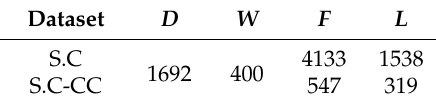
Table 3. The statistics of the S.cerevisiae (S.C) and S.cerevisiae-cellular component (S.C-CC) datasets.